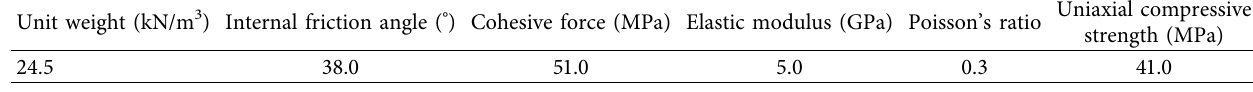
Table 1: Mechanical parameters of MDG soil layer.